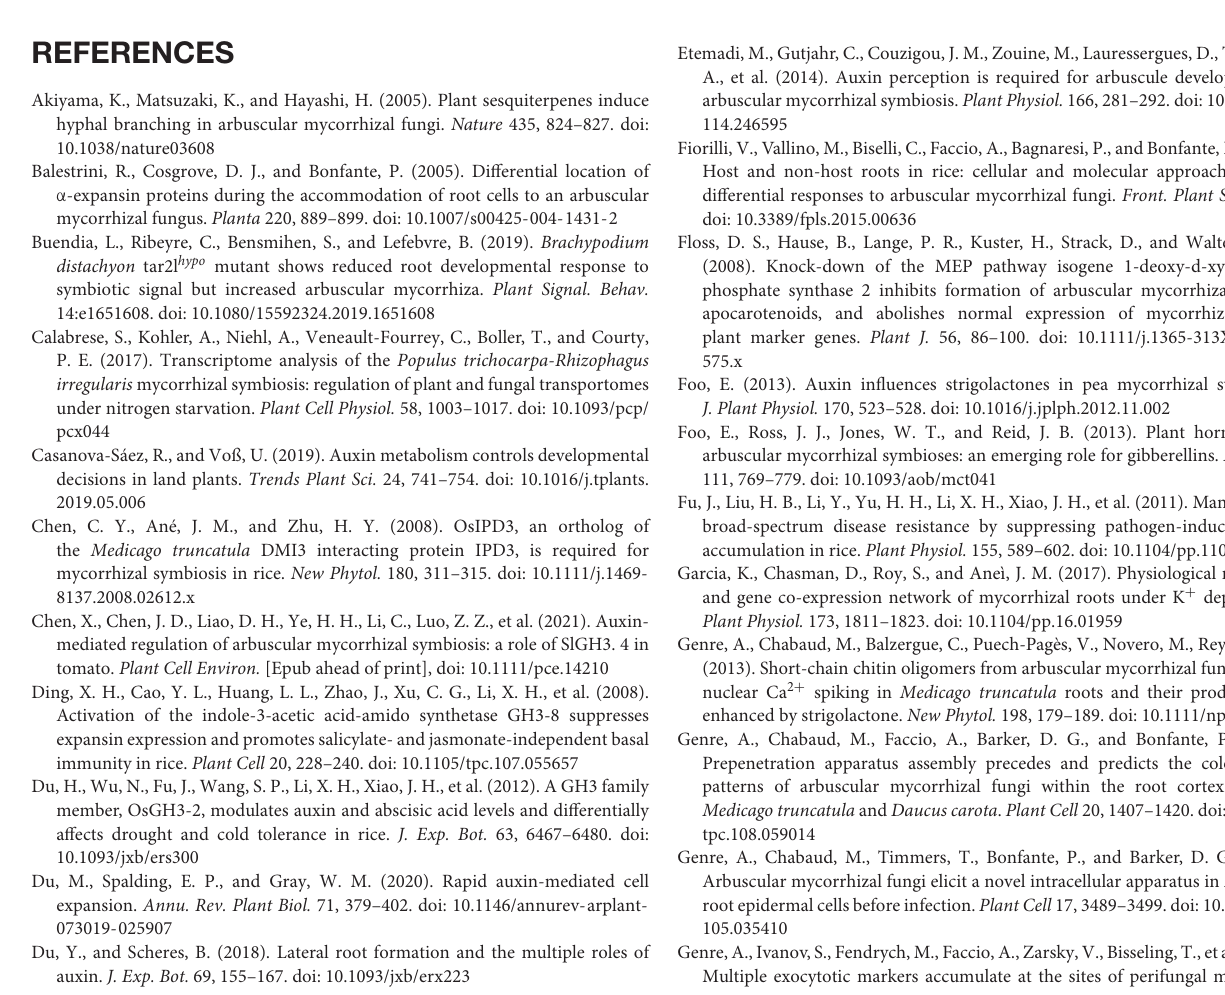
Supplementary Figure 3 | CRISPR/Cas9-mediated OsGH3.2 gene mutagenesis in rice. (A) The OsGH3.2 gene has three exons, with the GH3 domain (PF03321)-encoding region shown in orange. The target sites (red vertical rectangles) of two designed single-guide RNAs (sgRNAs) were located on the third exon. The red and green letters represent the target sequences and the protospacer adjacent motif (PAM) sites, respectively. (B) A total of six mutated alleles were identified, from which two alleles, Osgh3.2-1 and Osgh3.2-2 , were chosen to further obtain their homozygotes. (C) The deduced proteins of wild-type OsGH3.2 and two mutated alleles via Pfam (http://pfam.xfam.org) were shown. Supplementary Figure 4 | Osgh3.2 mutants showed altered root morphology. Rice roots of wild-type, Osgh3.2-1 and Osgh3.2-2 after hydroponic culture (A) or inoculation by R. irregularis (C) for 1 and 2 weeks. Scale bars, 1 cm. (B,D) Maximum length of crown roots (CRs), number of large lateral roots (LLRs) and number of CRs were compared between wild type rice and the Osgh3.2 mutants under two cultivation conditions, respectively. Data are individual values from 4 to 5 biological replicates. The horizontal lines indicate the mean values. Different letters indicate statistically significant differences (Student’s t -test, P < 0.05). Supplementary Figure 5 | Osgh3.2 mutants showed higher free IAA and tryptophan levels. (A,B) Free IAA and tryptophan (the IAA synthetic precursor) levels were measured in roots of both wild-type rice and Osgh3.2-1 mutant after hydroponic culture, respectively. Data are individual values from three biological replicates and the horizontal line shows the mean value. Statistical analysis was performed with Student’s t -test. Different letters indicate statistically significant differences ( P < 0.05).